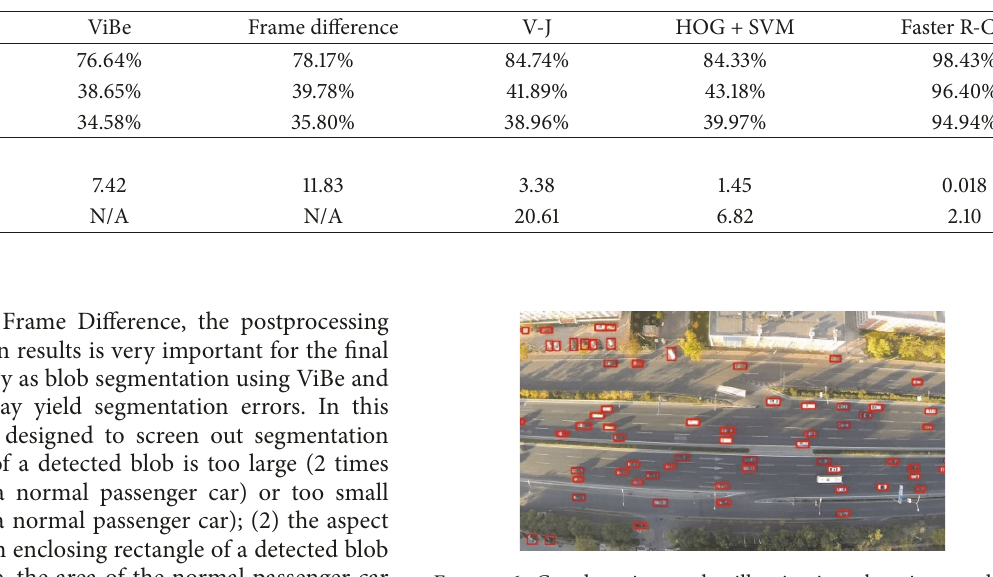
Table 1: Car detection results.